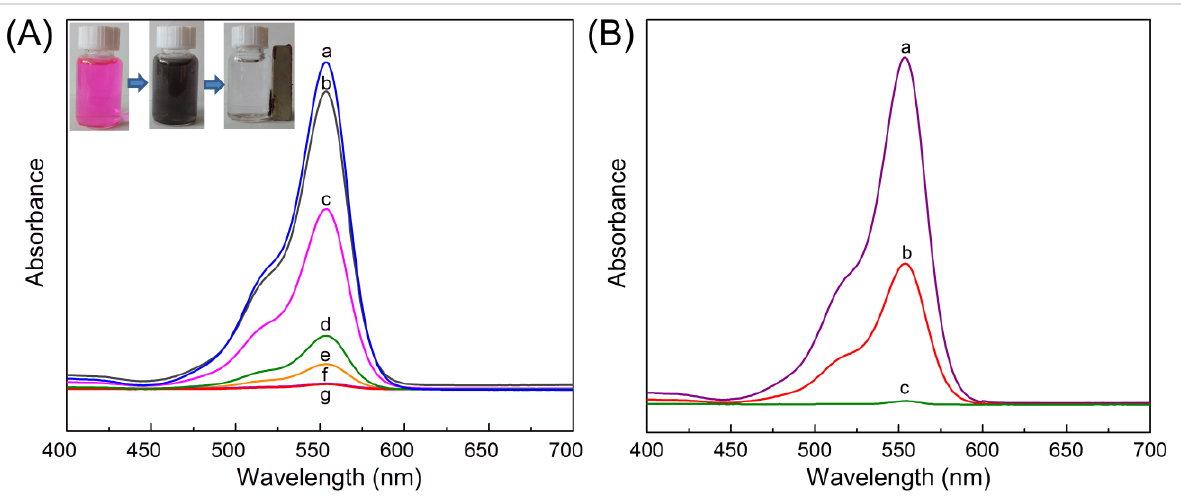
Figure 7: (A) UV–vis spectra of the solution after adsorption of RhB for 2 h in the absence of any adsorbents (a) and in the presence of the hexago- nal NPLs prepared by carbonization of LDH@PDA at 800 °C for 2 h (b–g). LDH@PDA samples were prepared with different initial dopamine hydro- chloride concentrations of: (b) 0, (c) 1.0, (d) 1.5, (e) 2.0, (f) 2.5, and (g) 3.0 g/L. (B) UV–vis spectra of the solution after adsorption of RhB for 2 h using the NPLs prepared by carbonization of LDH@PDA-2.5 at different temperatures for 2 h: (a) 500, (b) 650, and (c) 800 °C. The concentration of adsor- bents is 0.2 g/L and the initial concentration of RhB solution is 25